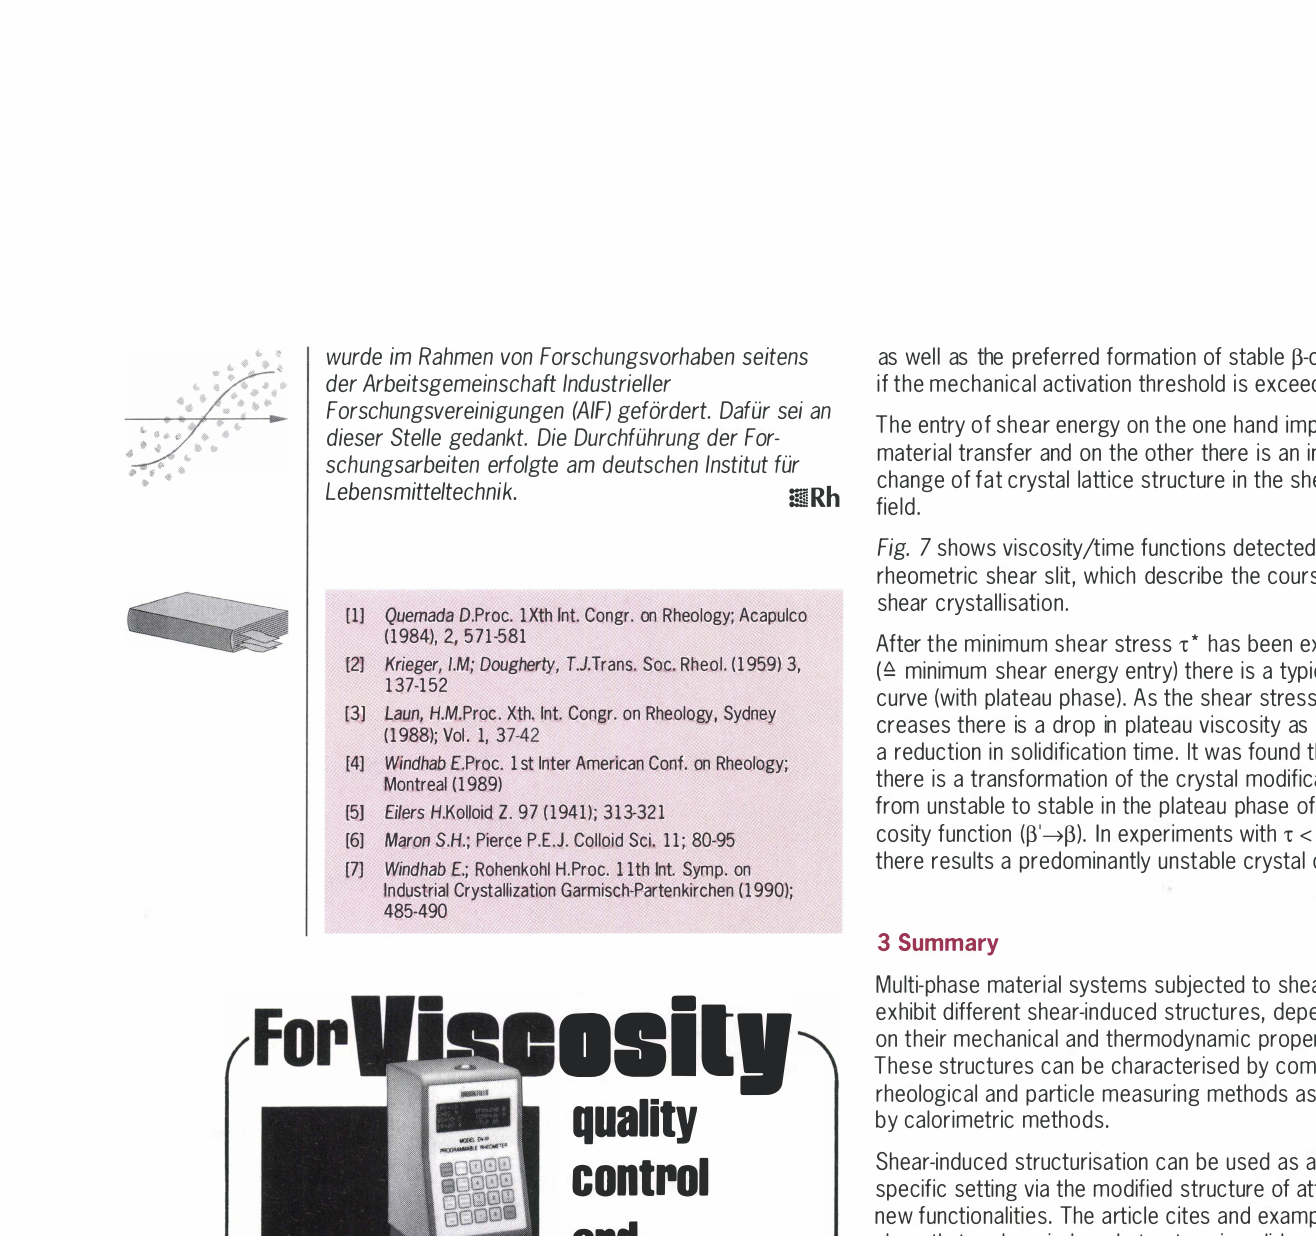
I B i ll quality control